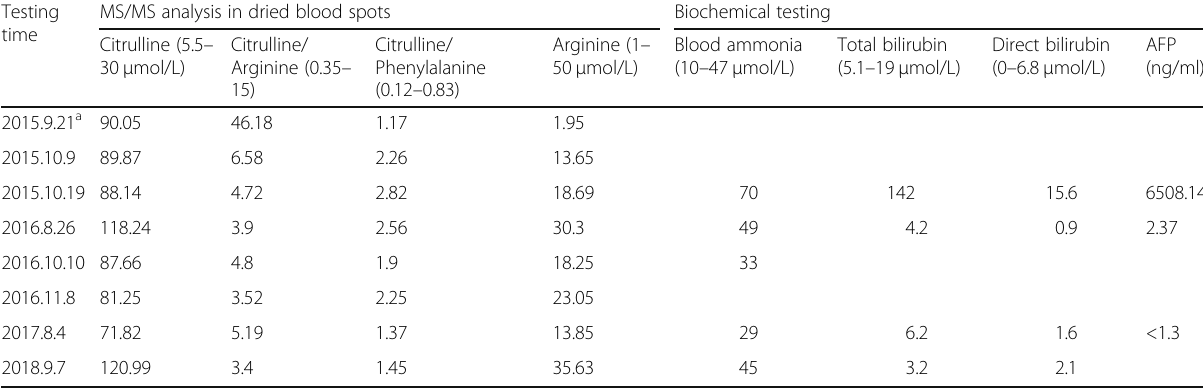
a Newborn screening